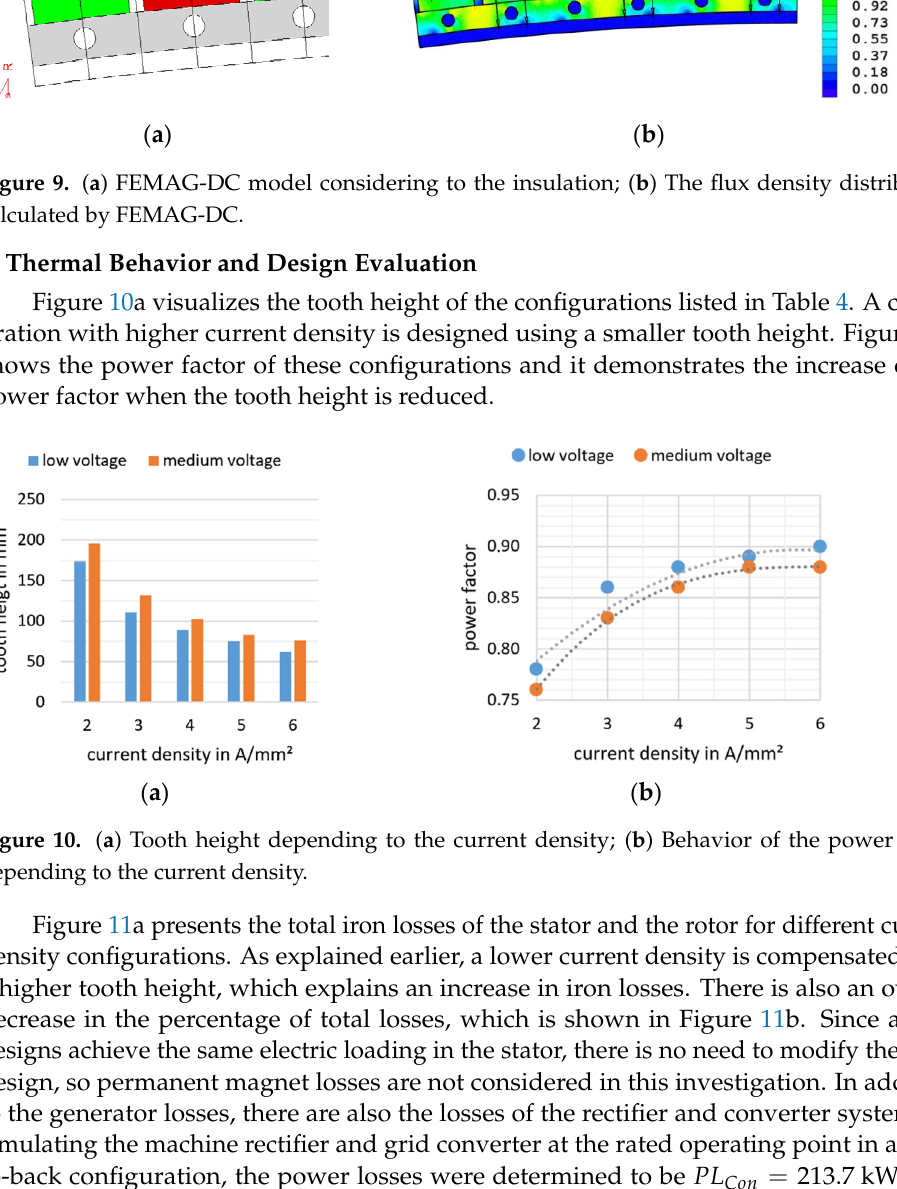
Table 4. Overview of the different design parameters depending on the current density.